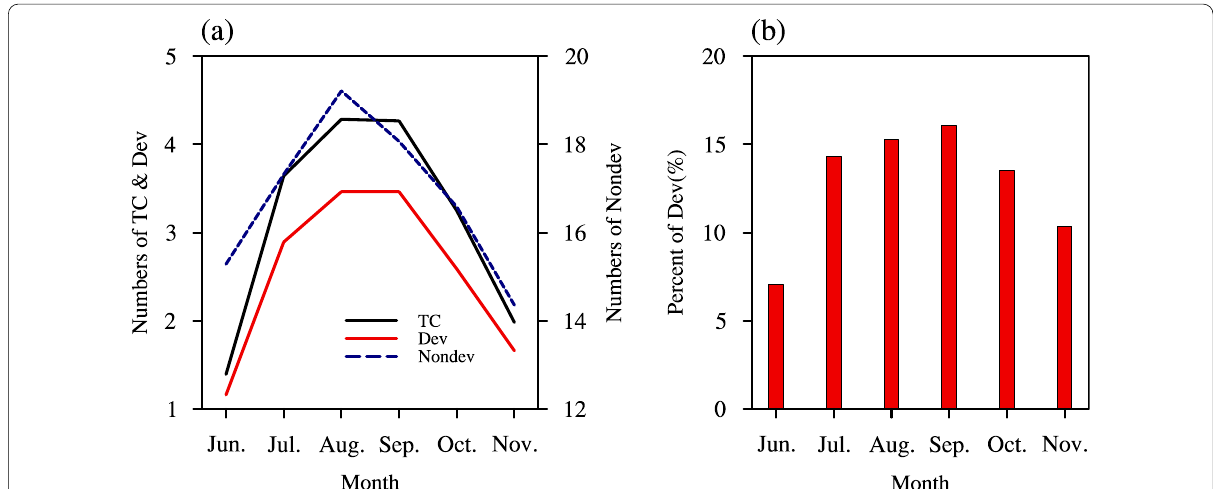
Fig. 4 a Histograms of monthly numbers of developing (solid red line) and nondeveloping (blue dotted line) disturbances and TCs (solid black line) over the WNP averaged during 1965–2020. b The percentage of the developing disturbances to all tropical